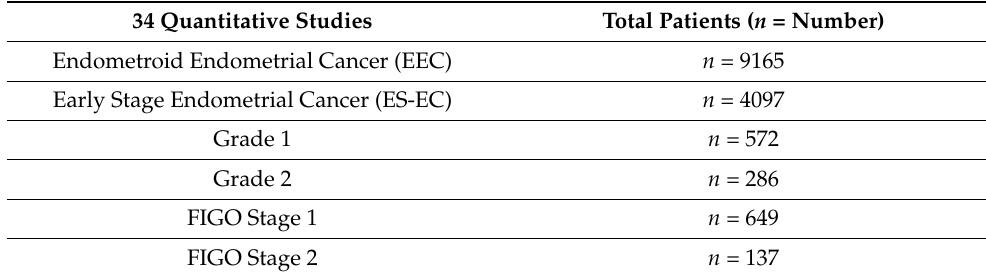
Table 2. Quantitative data of the final 34 Studies included in the